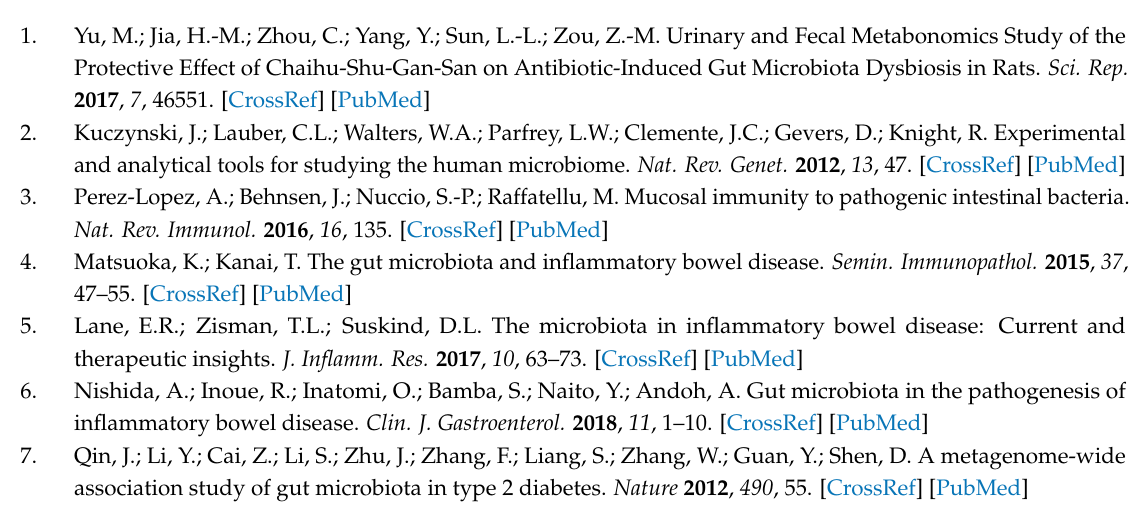
Figure S1: PCR-DGGE profiles of fecal samples using 16S rRNA gene, Figure S2: Box plot of richness estimators of the gut microbiota of mice in each treatment to determine differences in bacterial community diversity and richness, Figure S3: Hierarchical clustering of the gut microbiome, Figure S4: Bubble plots showing the relative abundances of the top ten abundant genera in mice fecal sample, Table S1: Summary of OTU sequencing data attained in this study, Table S2: Summary of alpha diversity indices estimation via 16S rRNA gene sequencing, Table S3: Percentage of bacterial phyla in different treatment groups, Table S4: Percentage of bacterial family in different treatment